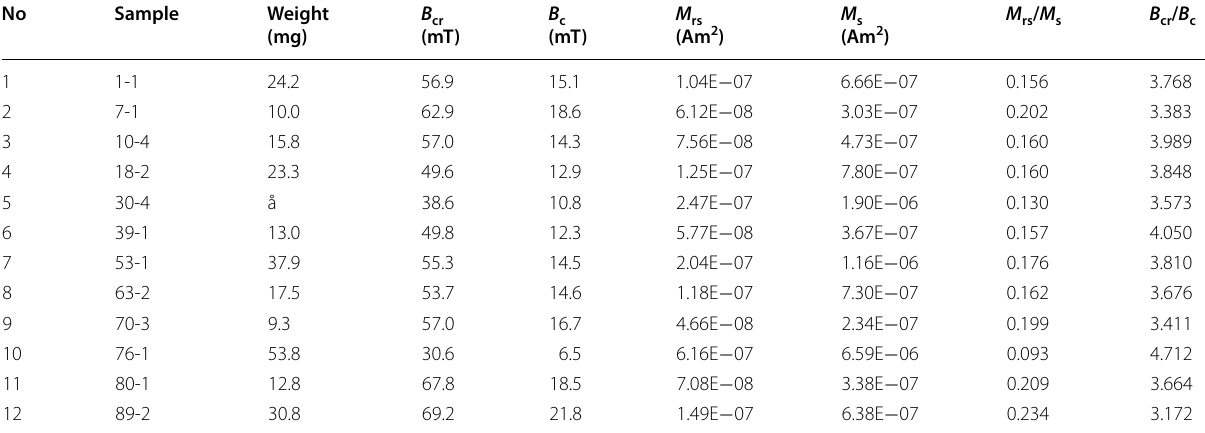
, B , M , and M ) of 12 selected samples cr c rs s